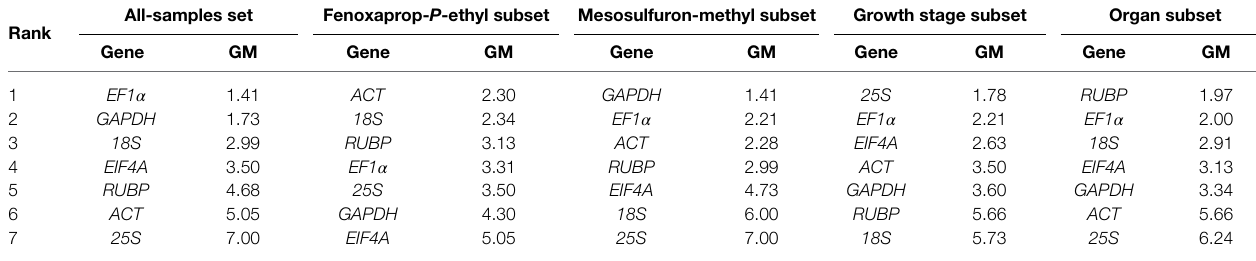
GM, geometric mean of